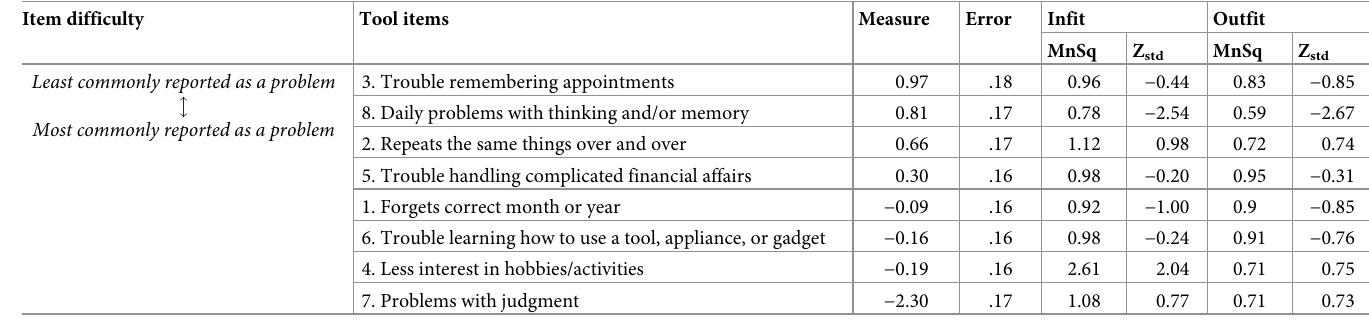
Table 2. Item fit statistics for the Ascertain Dementia Eight-Item Informant Questionnaire (AD-8). Item difficulty